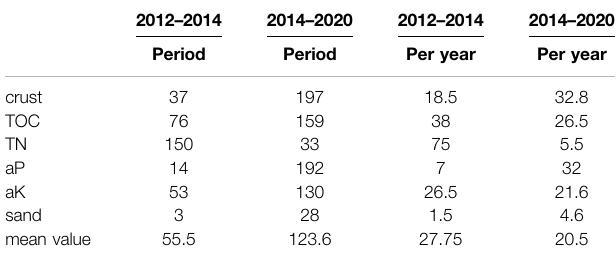
TABLE 3 | Percentage increase in calculated crust and soil parameter values for each year between 2012 – 2014 and 2014 – 2020 (individual and average of all